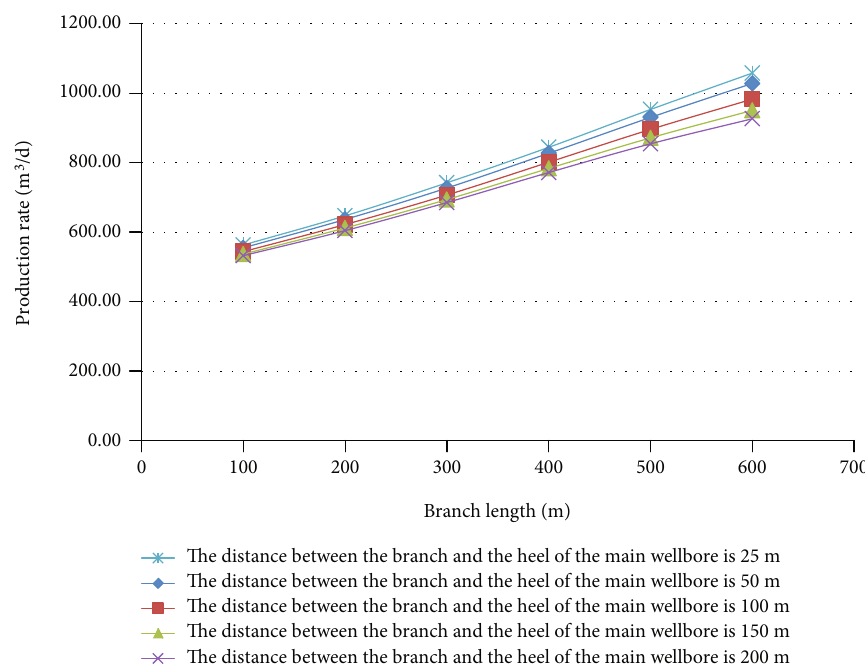
Figure 7: Production with di ff erent angles between the lateral well and main wellbore.